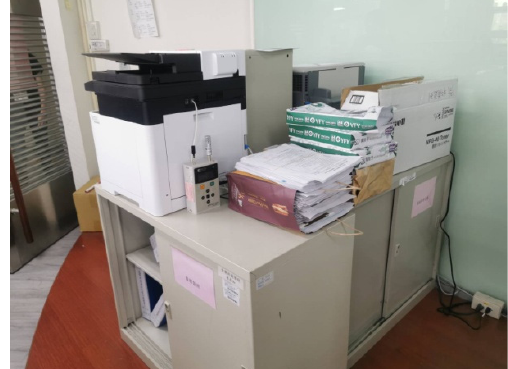
Figure 4. Detected device installed at photocopy area.